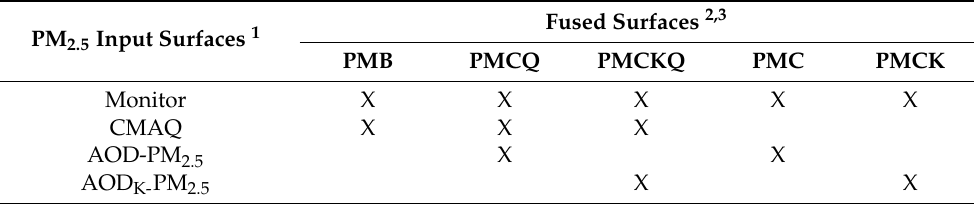
Table 2. Matrix of the four PM 2.5 input surfaces (first column) used to form the baseline PMB and the four experimental aerosol optical depth (AOD)-PM 2.5 fused surfaces (remaining columns). Fused Surfaces 2,3 PM 2.5 Input Surfaces 1 PMB PMCQ PMCKQ PMC PMCK Monitor X X X X X CMAQ X X X AOD-PM 2.5